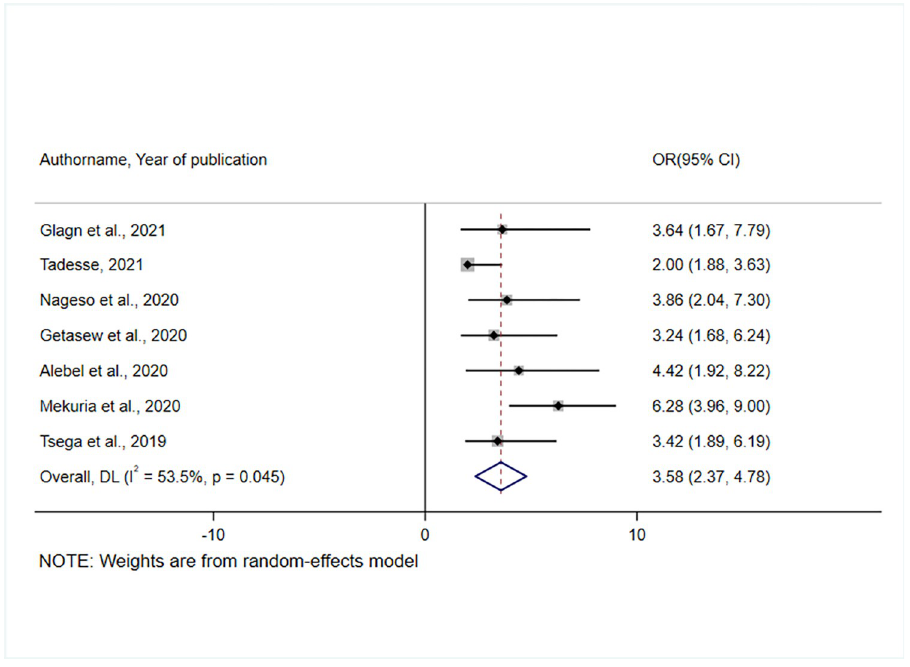
Fig 10. A forest plot showing the association between having a person in the household with a chronic disease and enrollment in the CBHI scheme in Ethiopia, 2017–2022.